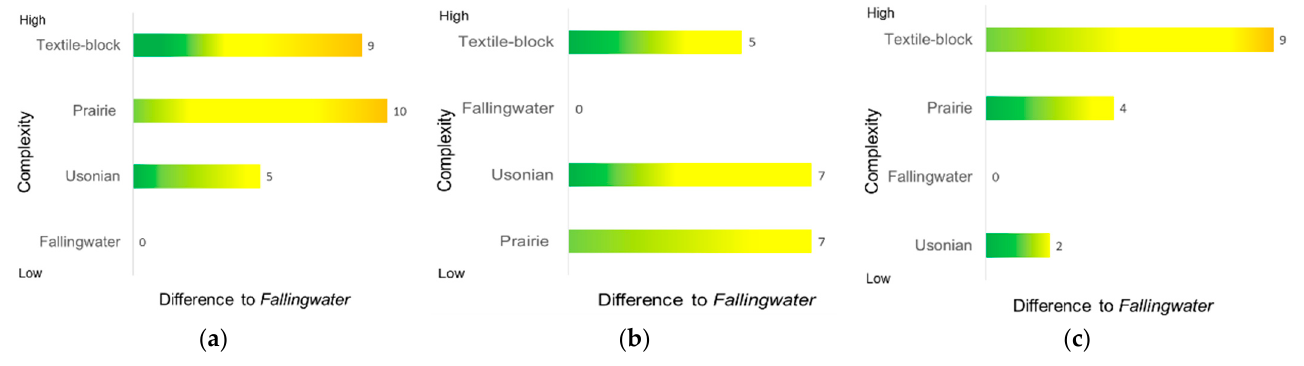
Figure 15. Fallingwater profiles: ( a ) Elevation, ( b ) plan, ( c ) elevation s+ plan.